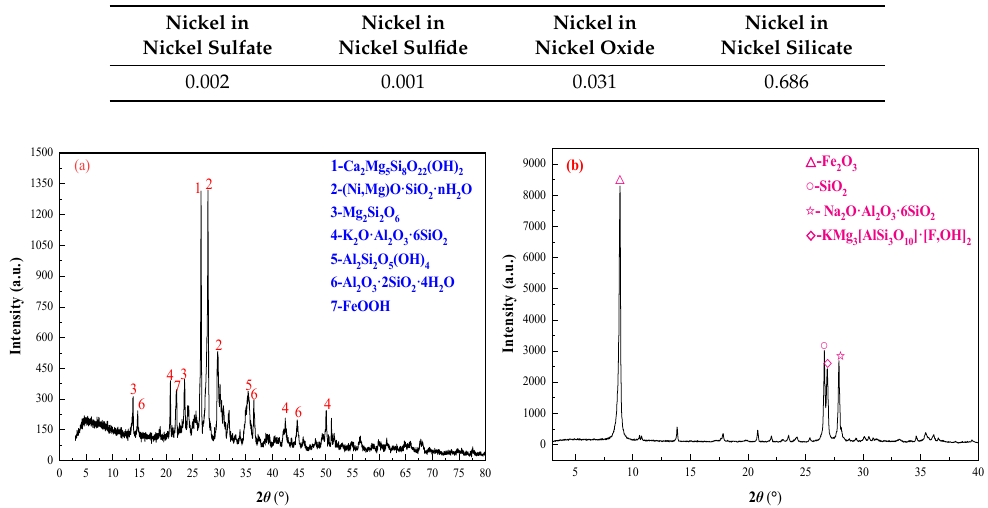
Table 3. Nickel phase analysis of garnierite laterite ore (%).